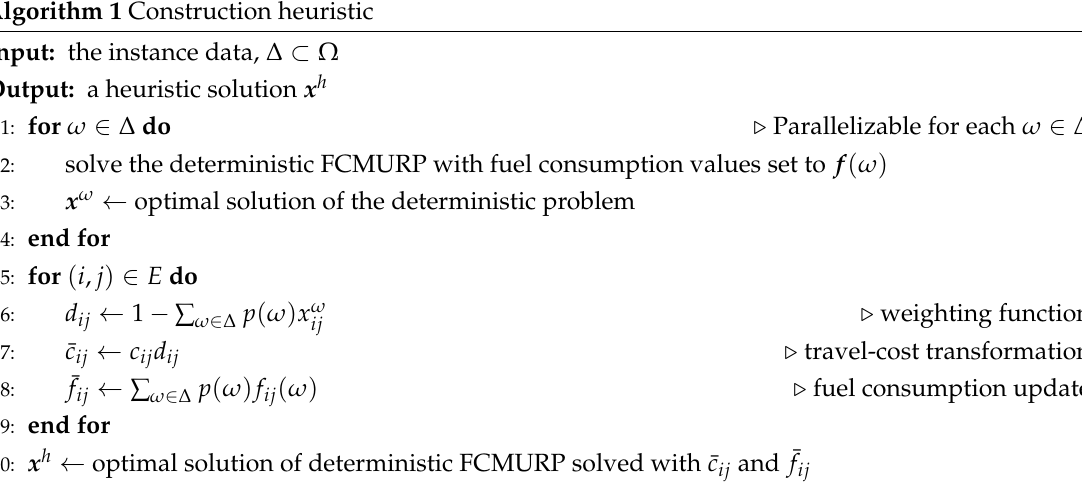
Algorithm 1 Construction